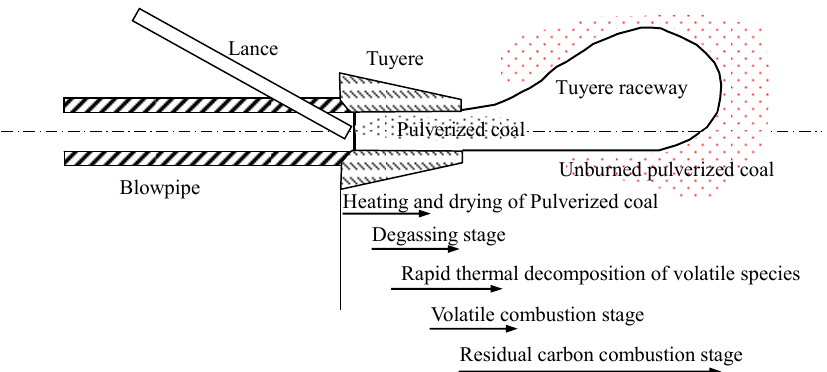
Figure 1. The combustion and gasification of the pulverized coal in the tuyere.